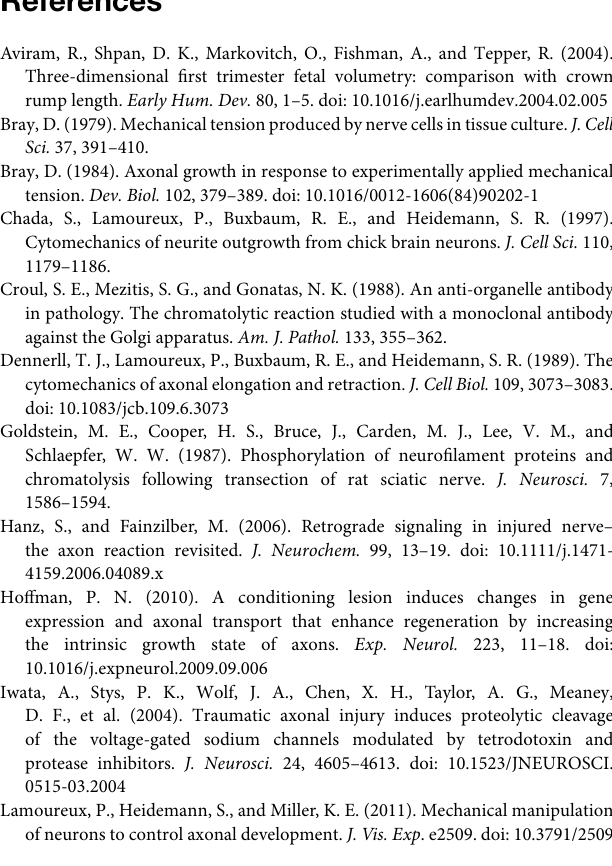
Figure S1 | Calcium increases following traumatic stretch injury. (A) Before injury, fluorescence intensity of Fluo-4AM is extremely weak in axons compared to somata. (B) Immediately following injury, increases in fluorescence intensity occur in both the soma and axons (arrow). (C) Nine minutes post-injury, fluorescence increases persist in a percentage of somata (arrow heads) and axons. Bar = 25 μ m. Supplementary Video 1 | Patch-clamp recording during real-time axon stretch. Subtle movement of neuronal somata occurs during real-time axon stretch. Supplementary Video 2 | Functional calcium imaging of real-time axon stretch (8DIV). A rise in intracellular calcium can be seen in a single cell after reaching 18% strain (6min mark, see arrow). Bar = 25 μ m. Supplementary Video 3 | Stretch-grown cultures following excessive stretch. Axons thin pathologically following excessive strain which reached 52%. Supplementary Video 4 | Membrane elasticity of neuronal somata. Following patch clamp recording, a recording electrode is manipulated away from a cell while the membrane remains intact and undergoes 50 μ m stretch. Supplementary Video 5 | Functional calcium imaging of traumatic stretch injury. A traumatic stretch-injury causes ubiquitous calcium spiking at the time of stretch-injury (1min